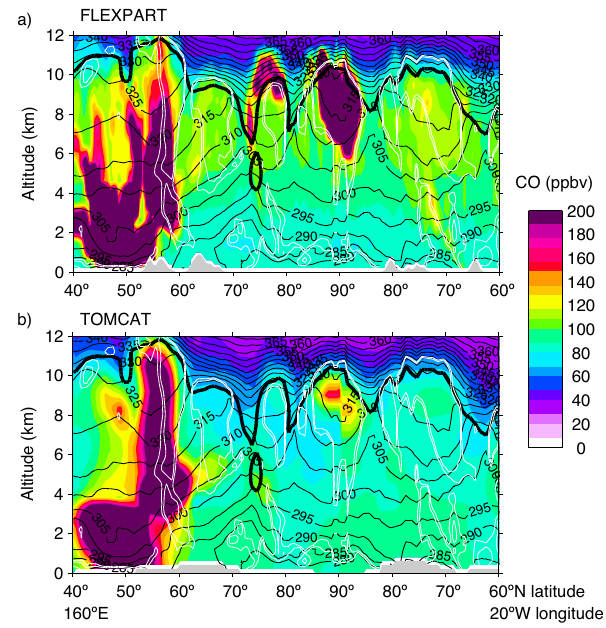
Fig. 3. Vertical cross-sections of CO concentrations in ppbv through the Arctic atmosphere on 4 July 2008 00:00UTC from 60 ◦ N to 40 ◦ N along 160 ◦ E/20 ◦ W through (a) the FLEXPART simulation and (b) the TOMCAT simulation. Meteorological conditions are shown by contours of potential temperature (thin black lines), rel- ative humidity (80 and 90 percent, white solid lines), and the dy- namical tropopause (2pvu, thick black line) from ECMWF analysis